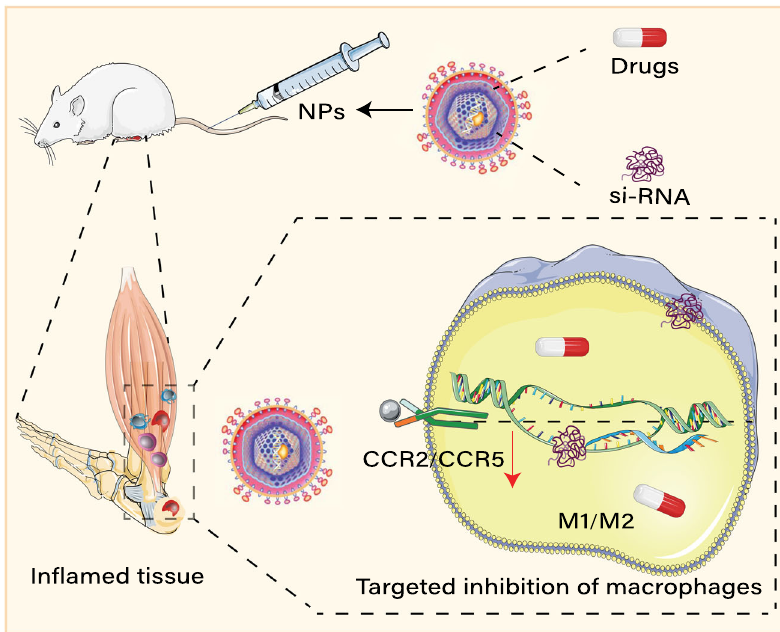
Fig. 4 Macrophages targeted nanomedicine. Macrophages of different phenotypes in in fl amed tissues can be targeted by injecting speci fi c nanoparticles. Drug-loaded NPs, such as chlorophosphate-containing liposomes, blocks HO formation by depleting macrophages. In addition, NPs loaded with siRNA can inhibit the recruitment of macrophages and the secretion of in fl ammatory mediators by downregulating the expression of CCR2 or CCR5, which may be a new approach for the prevention of